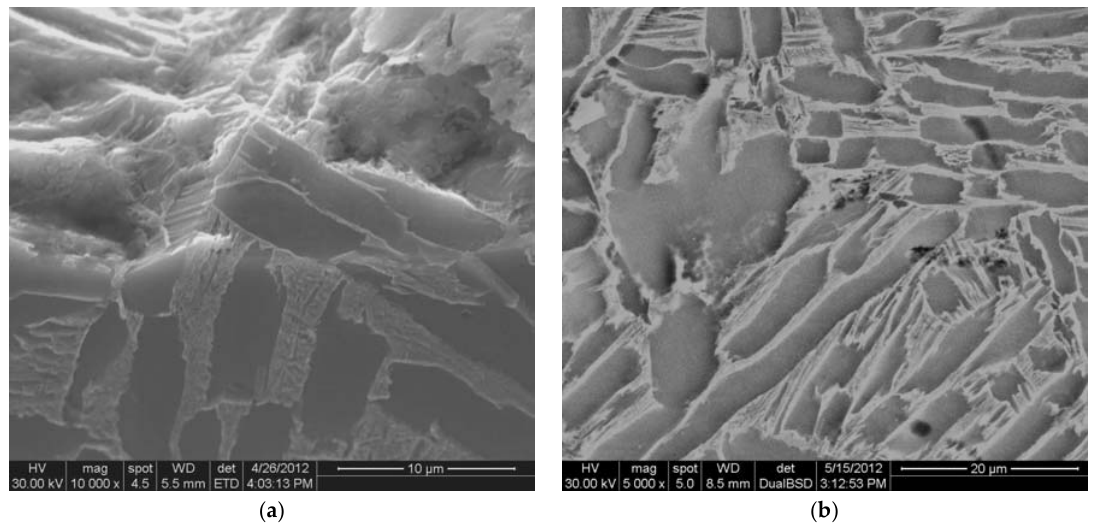
Figure 7. Fatigue crack initiation and microstructure characteristics with basketweave of 40 µ m: ( a ) surface initiation, σ = 610 MPa, N = 1.15 × 10 6 cycles; ( b ) subsurface initiation, σ = 540 MPa, N = 8.51 × 10 7 cycles.